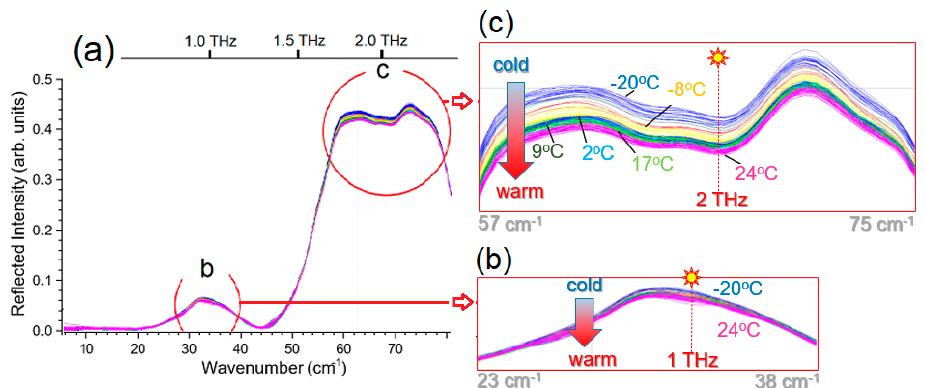
Figure 6. Raw data, spectral reflected signal intensity for Lurpak ® butter. ( a ) Reflected signal inten ‐ sity in arbitrary units from − 20 °C to 24 °C. ( b ) Highlight, reflected signal intensity Lurpak ® butter in the range of wavenumber 23 to 38 cm − 1 (~0.7 to 1.15 THz). ( c ) Highlight, of Lurpak butter in the range, wavenumber 57 to 75.0 cm − 1 (~1.70 to 2.25 THz).